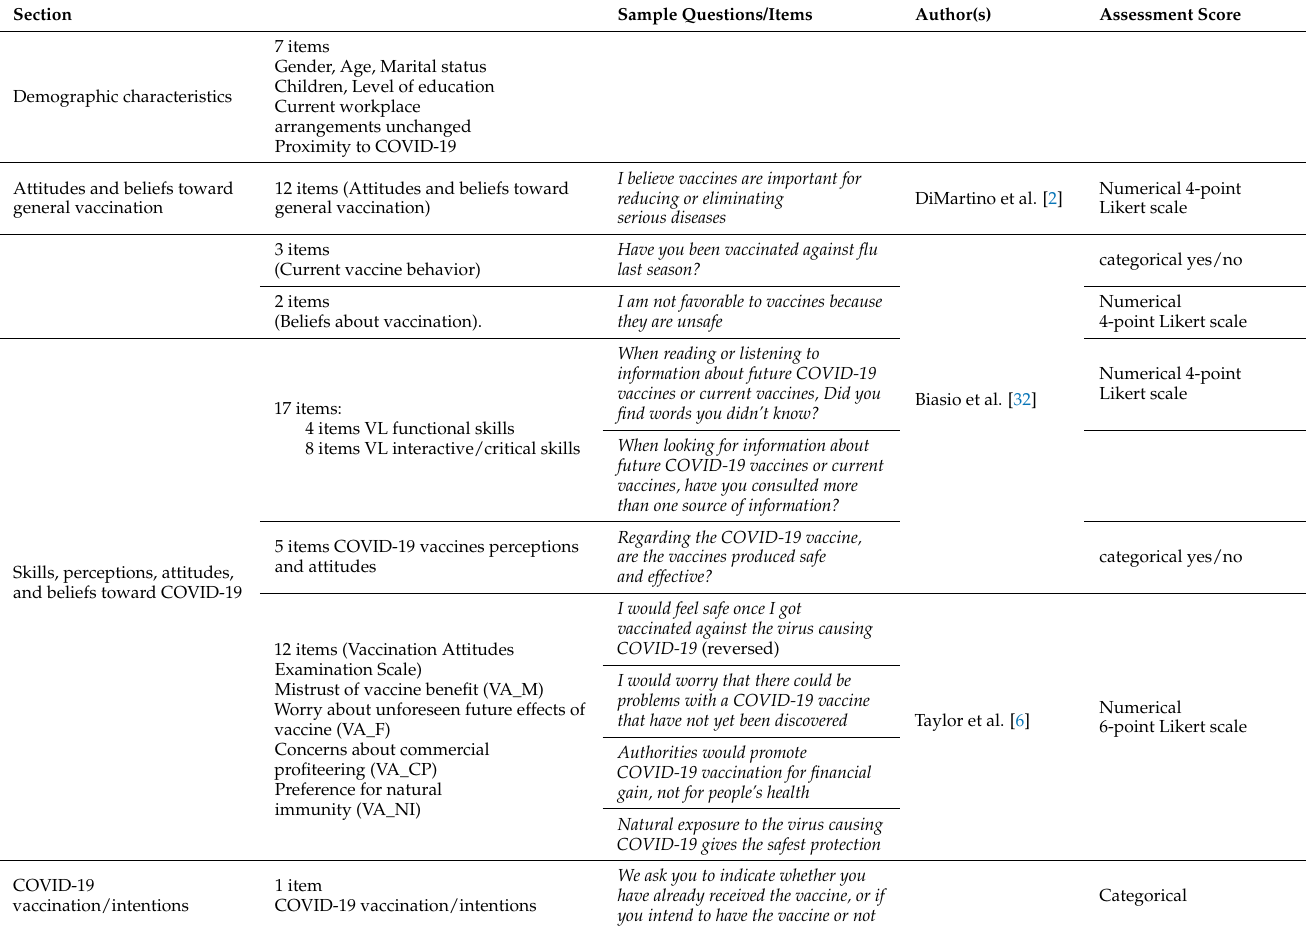
Table 1. The measure of the